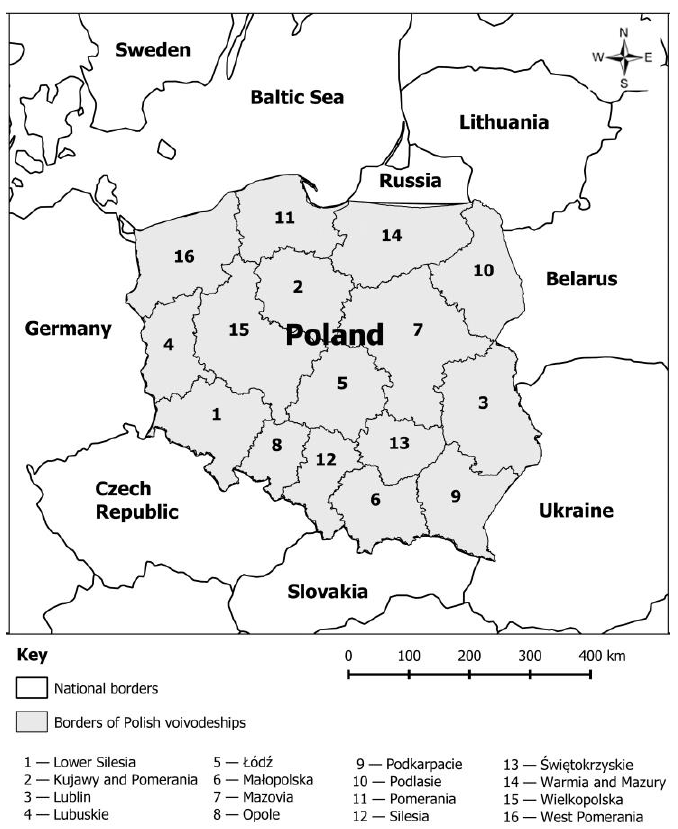
Figure 1. The location of the research object. Source: own elaboration.